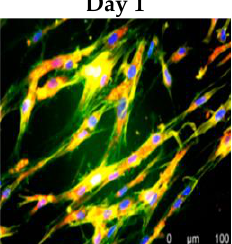
Figure 18. Fluorescent images of VECs on top layer of the VECs-VICs co- culture model * β1 Integ- rin — green; F-actin — yellow; Nuclei — blue; Cell membrane —red (scale bar: 100 μm) . Adapted with permission from ref. [231]. Copyright 2018, MDPI. Collagen-chitosan (COL-CH) composite films, with a mass ratio of 7:1 (COL:CH), have proved to be a suitable material for scaffolding, due to their moderate flexibility, high resilience and resistance to tension. Moreover, COL-CH composites formed 3D struc- tures with interconnected pores, and dimensions appropriate for tissue-engineered scaf- folds in the range of 80 — 260 mm. The COL-CH scaffolds were seeded with three types of cells harvested from New Zealand white rabbits, resulting in four groups: SMC group — smooth muscle cells (SMCs) and fibroblasts (FIs); EC group — endothelial cells (ECs); ( SMC+EC) group — SMCs, fibroblasts and ECs; and blank control group — without cells, re- spectively. Each cell group was seeded twice, waiting 24 h between cell seeding. The first seeding of SMCs and FIs improved the scaffold environment for the further ECs adhesion, differentiation and growth. Moreover, the sequential seeding of SMCs, FIs and then ECs into the valve scaffolds led to significant increases in the secretion of 6-keto-PGF1a com- pared with scaffolds seeded with ECs alone. Thus, the seeded ECs not only adhere and proliferate, but also secrete vasoactive substances, demonstrating the biological activity of the manufactured composite scaffolds. SEM images, for the SMC group , showed a large number of cells inside the scaffolds with dense disordered arrangement, while for the